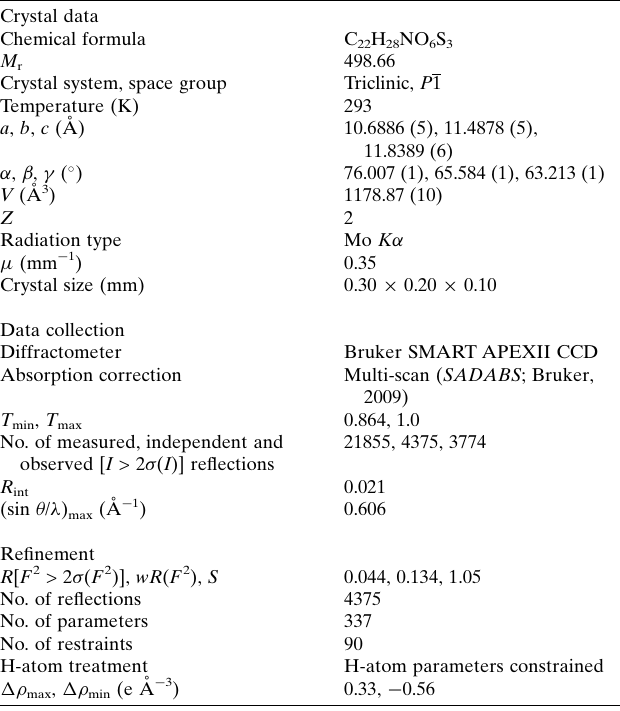
Table 2 Experimental details. Crystal data Chemical